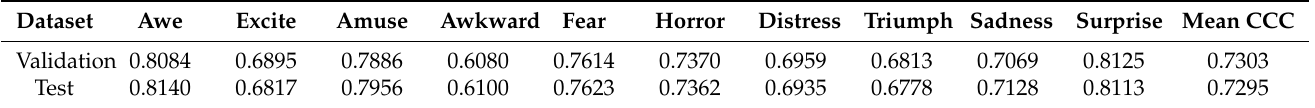
Table 2. Evaluation on each emotion on validation and test dataset based on CCC metric of our proposed